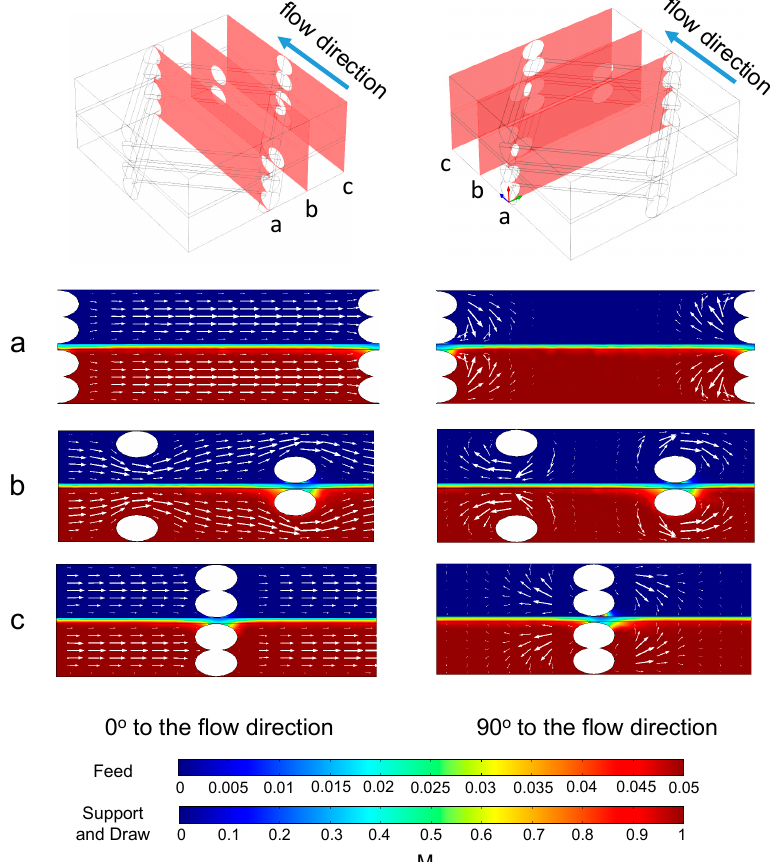
Figure 11. Concentration profile (indicated by the color flood) and velocity profile (indicated by the arrows) in the sections ( a – c ) of the 3D model corresponding to the diagrams at the top of each column. Velocity was 0.01 m/s. For each cross section, the size of the arrows is proportional to the value of the velocity.